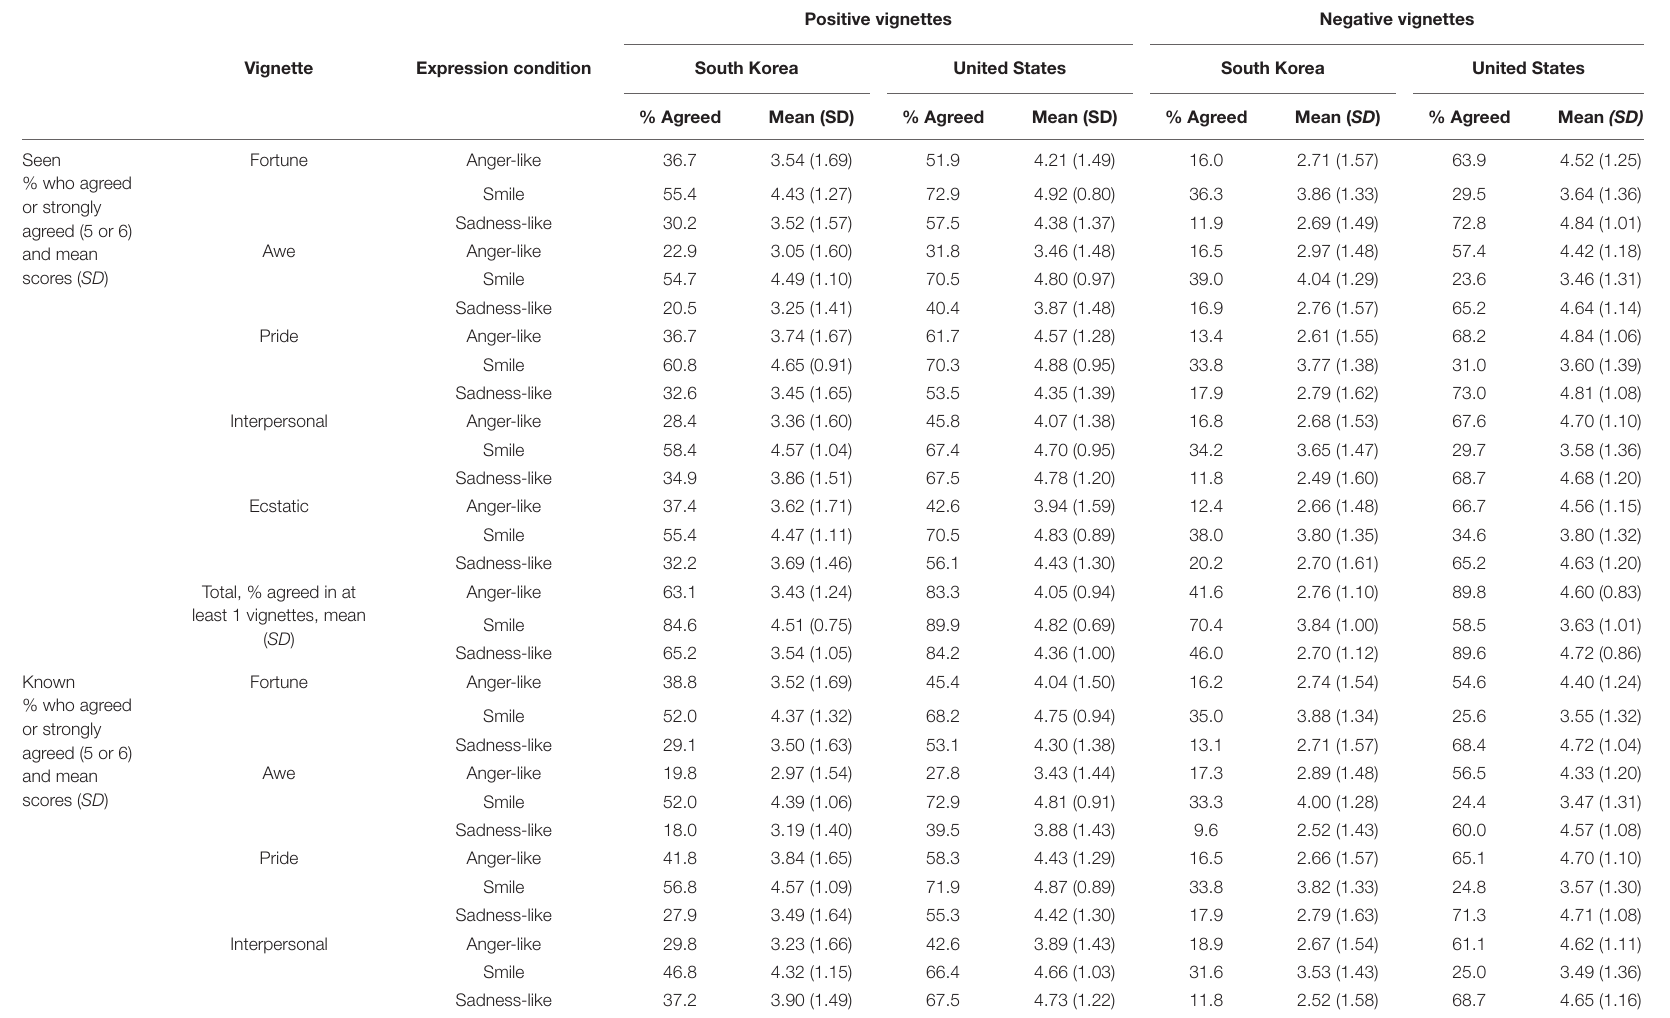
TABLE 1 | Descriptive statistics for the seen, known, and used the expression